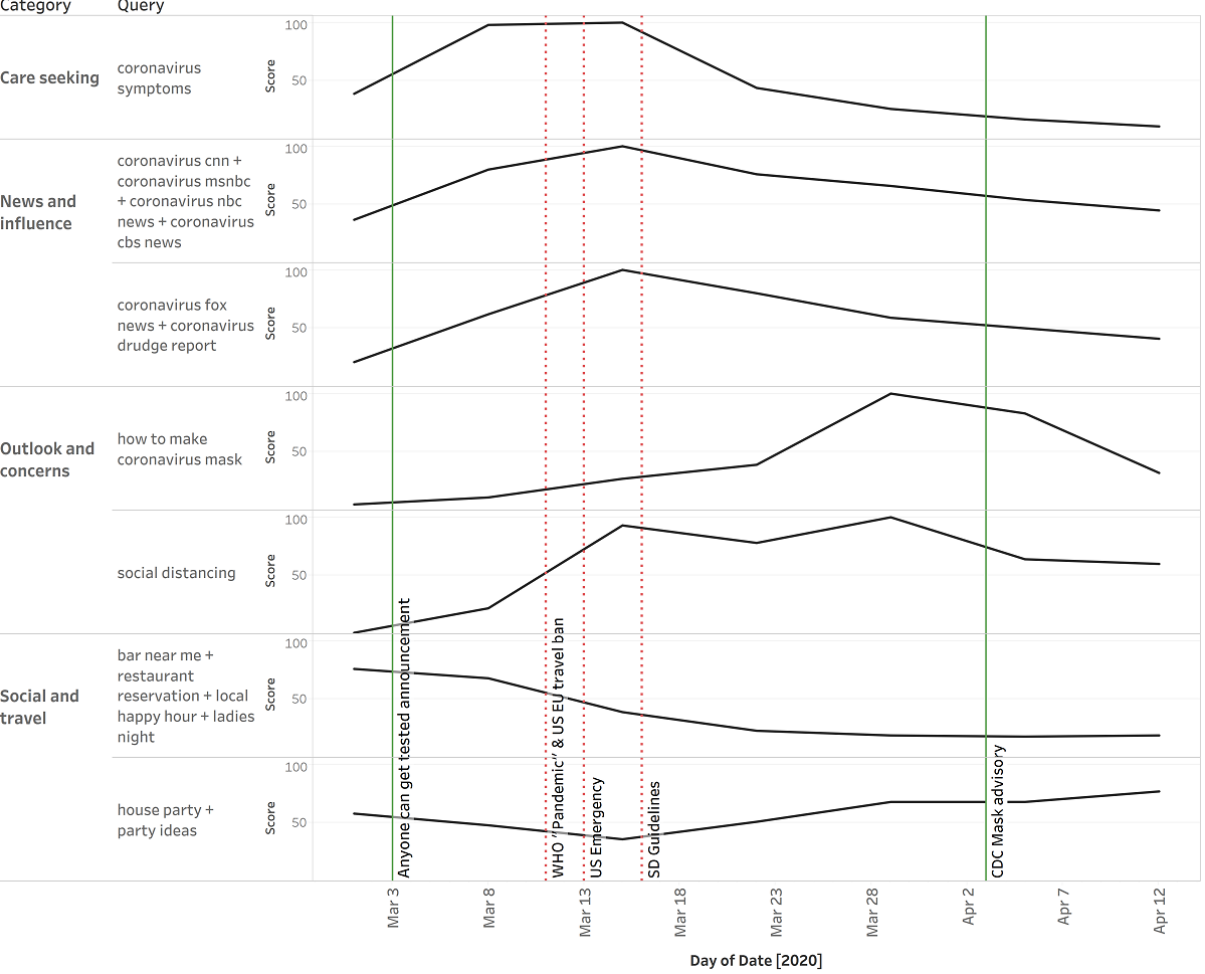
Figure 2. National trends for Google Trends nonpharmaceutical intervention–related queries compared to actual government and public health nonpharmaceutical interventions at the US federal level between March 1 and April 15, 2020. CDC: US Centers for Disease Control and Prevention; EU: European Union; SD: social distancing; WHO: World Health